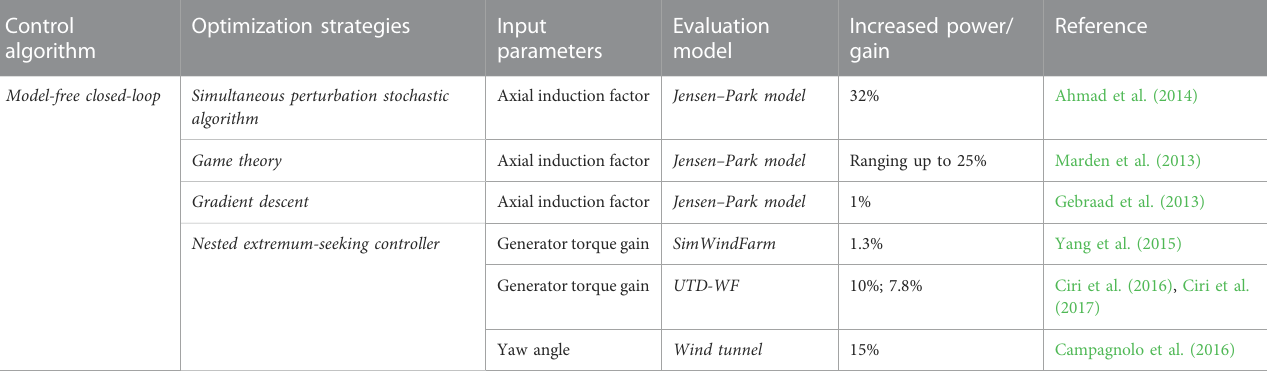
TABLE 7 Performances of model-free closed-loop control strategies with evaluation